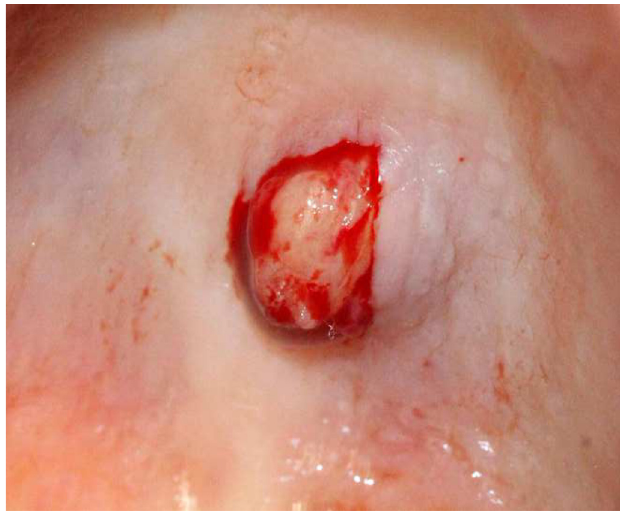
Fig. 3. Surgical excision of the tumor disclosing a solid, well- delimited, non-adherent homogeneous mass. The excision was